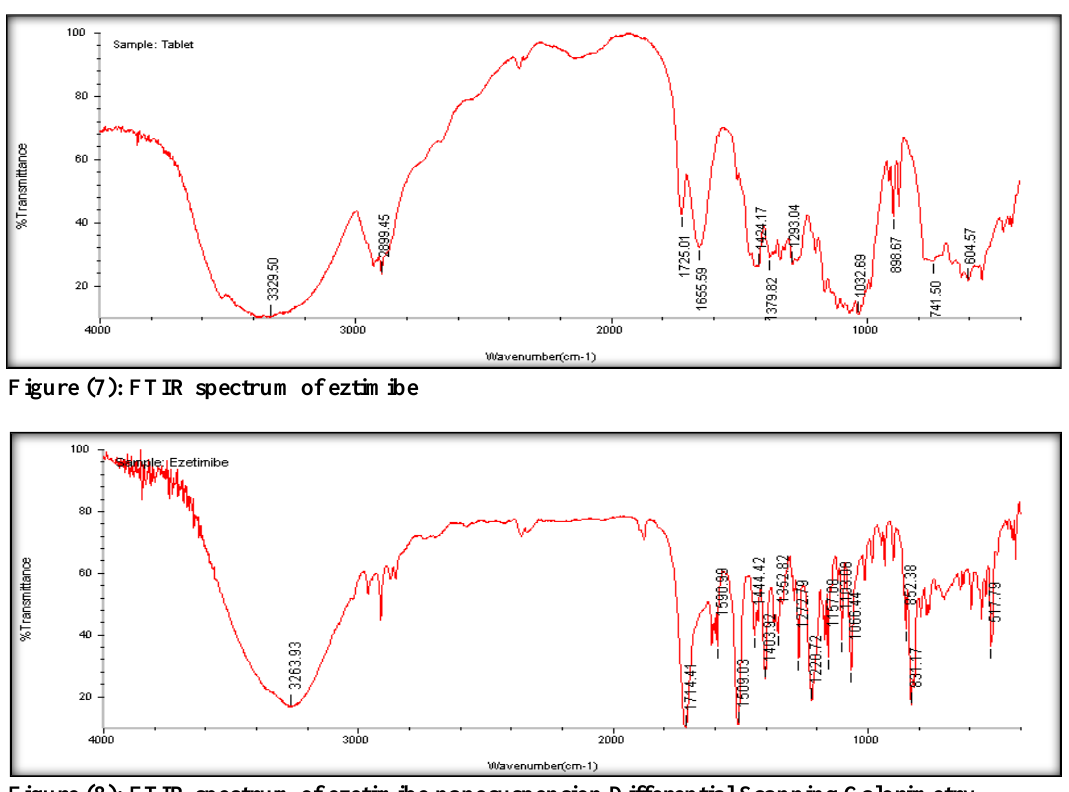
Figure (8): FTIR spectrum of ezetimibe nanosuspension Differential Scanning Calorimetry